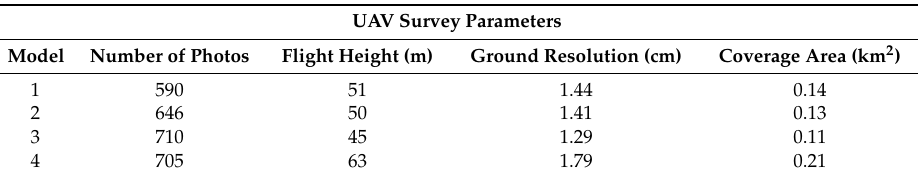
Table 1. Main parameters of the four UAV